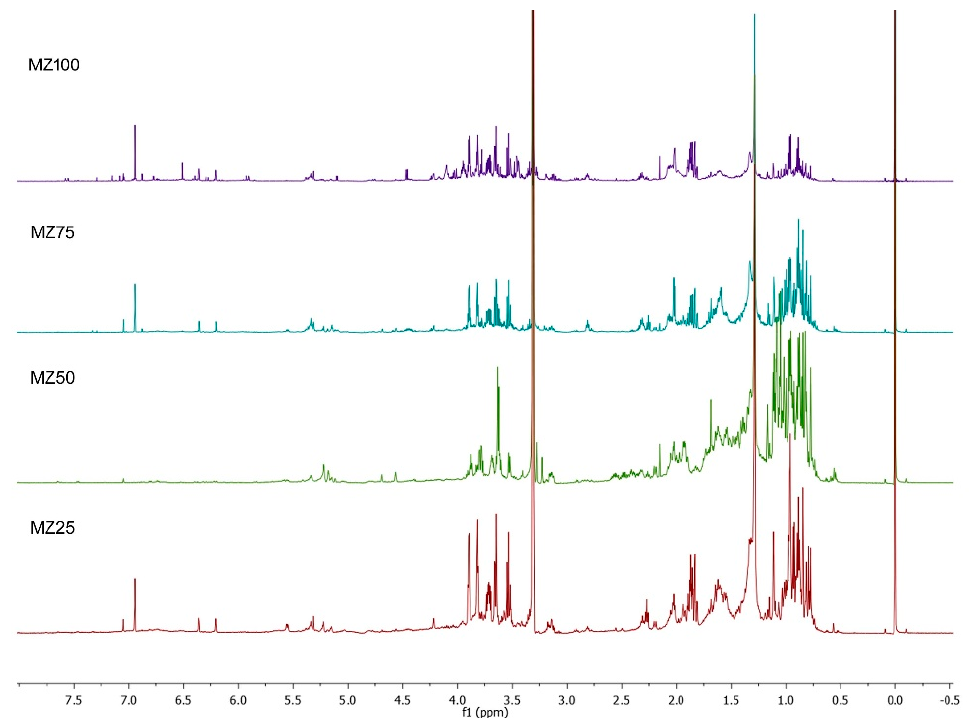
Figure 2. Representative 1 H-NMR profiles (Region δ 0 to 8) of the MeOH extracts from M. zapota leaves dried at different temperatures (T = 25, 50, 75 and 100 °C).